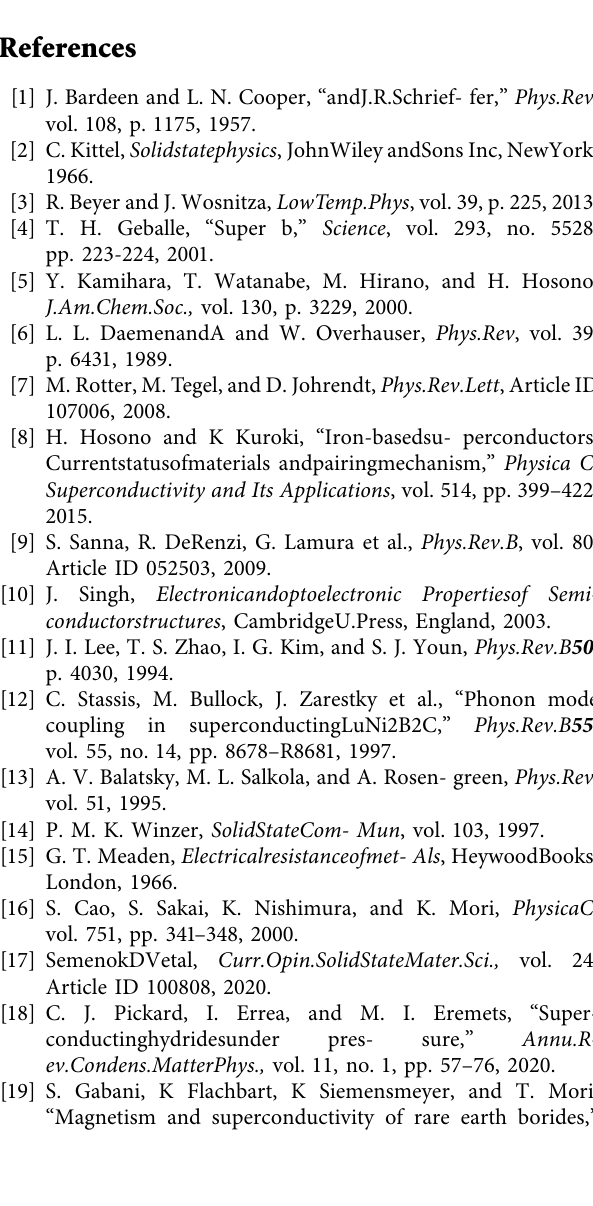
Figure 2: The electronic thermal conductivity of ErNi normal state versus